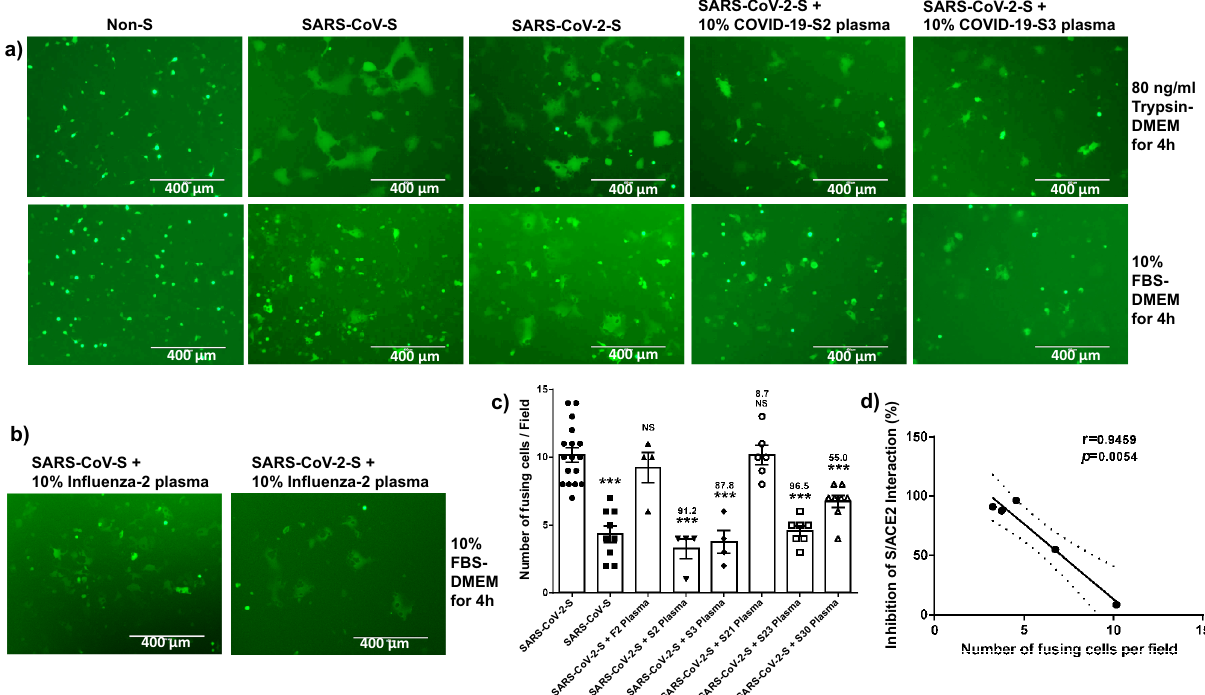
Figure 3. Convalescent plasma from COVID-19-recovered subjects inhibits cell–cell fusion mediated by the S-ACE2 interactions. ( a ) The effector cells: non-S-transfected 293 T (EGFP-alone), SARS-CoV-S-transfected 293 T, SARS-CoV-2-S-transfected 293 T, or SARS-CoV-2-S-transfected 293 T cells were incubated with 10% COVID-19 S2 plasma. SARS-CoV-2-S-transfected 293 T cells with 10% COVID-19 S3 plasma were incubated with the ACE2/293 T target cells for 4 h with 80 ng/ml of trypsin-DMEM (upper panel) or 10% FBS-DMEM (lower panel). ( b ) Plasma from Influenza-recovered subject cannot inhibit cell–cell fusion mediated by the S-ACE2 interactions. ( c ) The number of cell–cell fusions induced by SARS-CoV-S, SARS-CoV-2-S, and SARS- CoV-2-S following pre-incubated with 10% COVID-19 S2, S3, S21, S23, S30 or F2 plasma are shown (* P < 0.05, ** P < 0.01, and *** P < 0.001, respectively; the numbers on top of the bars represent the inhibition extent percentiles of S/ACE2 interaction of the convalescent plasma). d) The correlation between the inhibition extent of S1/ACE2 interaction and the number of fusing cells per field were shown. The graphs in c and d were created by Prism 6.01 software (https ://www.graph